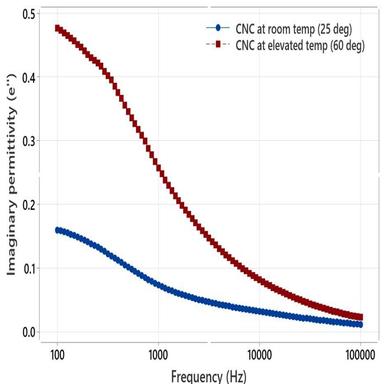
Imaginary permittivity of CNC at room (25 ℃) and elevated (60 ℃) temperatures.